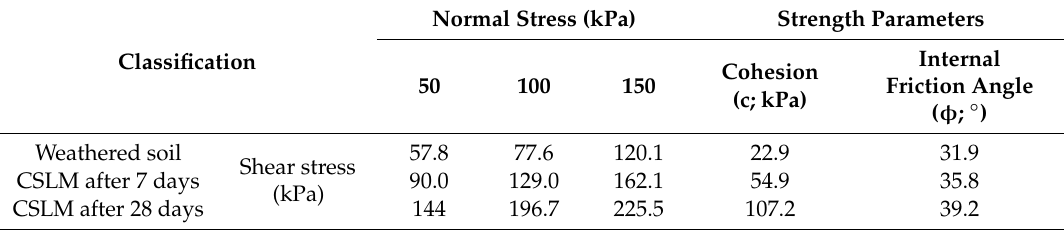
Table 7. Comparison of shear strength between weathered soil and CLSM with WPSA.